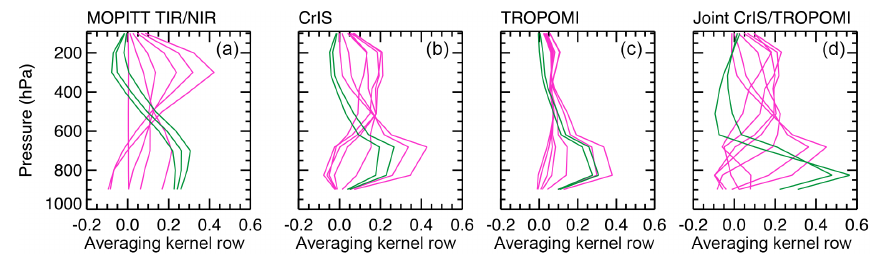
Figure 4. Sample averaging kernels of measurements for the target scene near 22.99 ◦ E, 8.65 ◦ S. In all panels, green lines are the averaging kernels from the surface to 3km ( ∼ 700hPa); magenta lines are the averaging kernels from 3km ( ∼ 700hPa) to 100hPa. (a) MOPITT joint NIR–TIR measurements; (b) Suomi NPP CrIS TIR measurements; (c) synthetic S5p TROPOMI NIR measurements; (d) synthetic joint CrIS–TROPOMI (TIR–NIR) measurements.